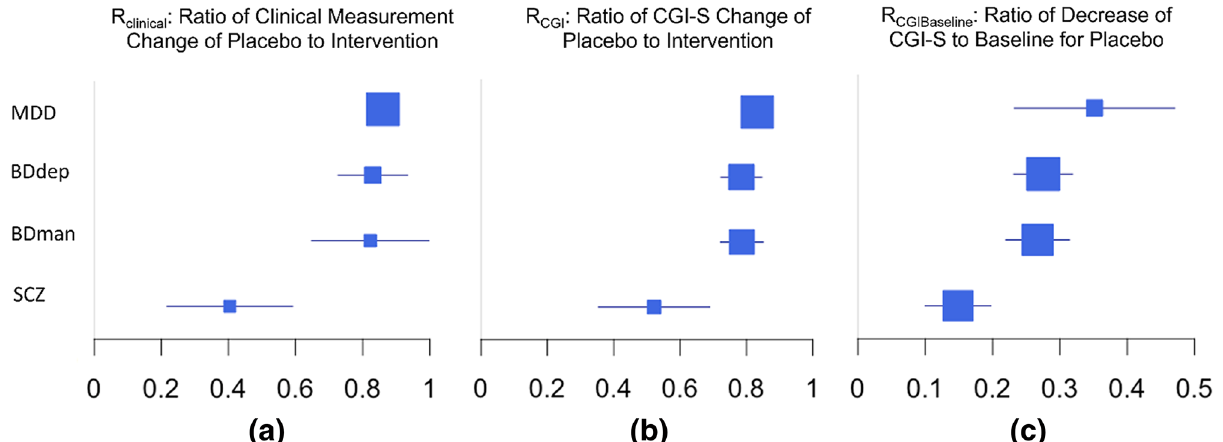
Figure 2. Differential placebo effect for MDD, bipolar disorder-depression (BDdep), bipolar disorder-mania (BDman), and SCZ, as measured by R clinical , R CGI and R CGI Basline . The box size indicates power estimates, a larger box representing a smaller range of confidence